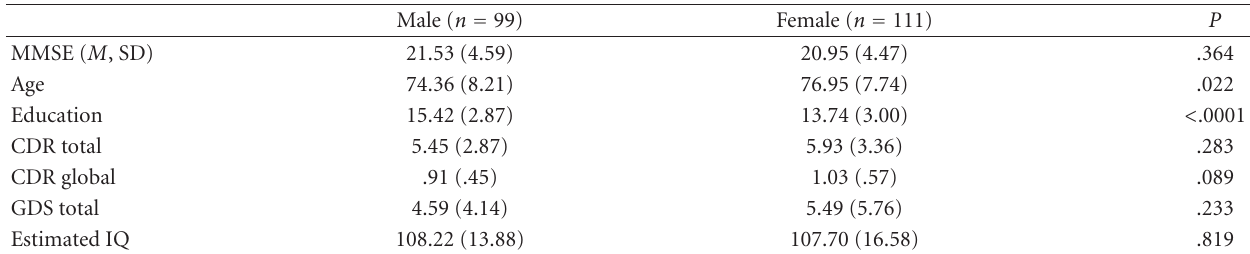
Table 1: Demographic characteristics of the